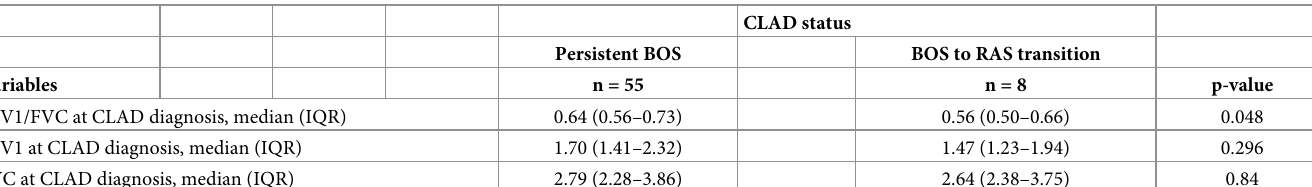
Table 2. Pulmonary function tests at CLAD onset.